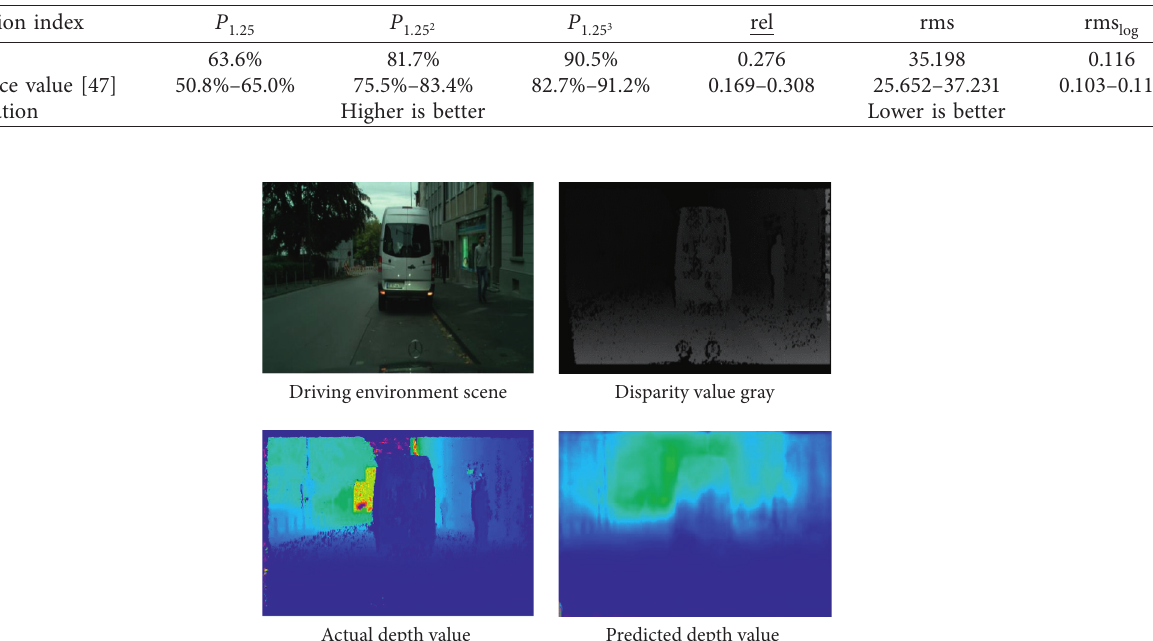
Table 2: Depth estimation accuracy.